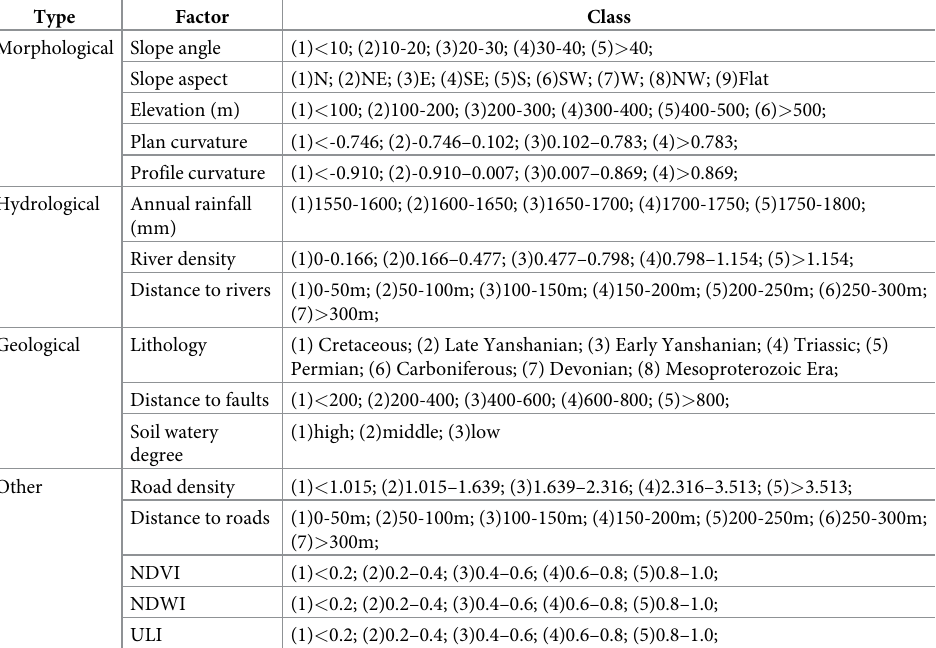
Table 1. Landslide affecting factors and their